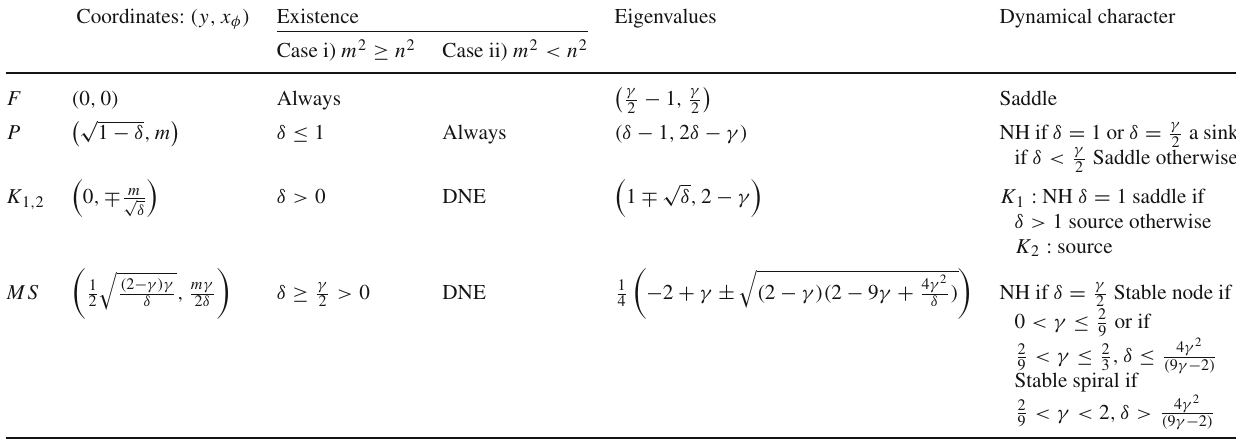
Table 3 The equilibrium points for zero-curvature models with the scalar field related by a linear function. “DNE” is used when an equilibrium point does not exist.“NH” is used when an equilibrium point is non hyperbolic. We use the notation δ = m 2 − n 2 . It is assumed 0 < γ < 2 Coordinates: ( y , x φ ) Existence Eigenvalues Dynamical character Case i) m 2 ≥ n